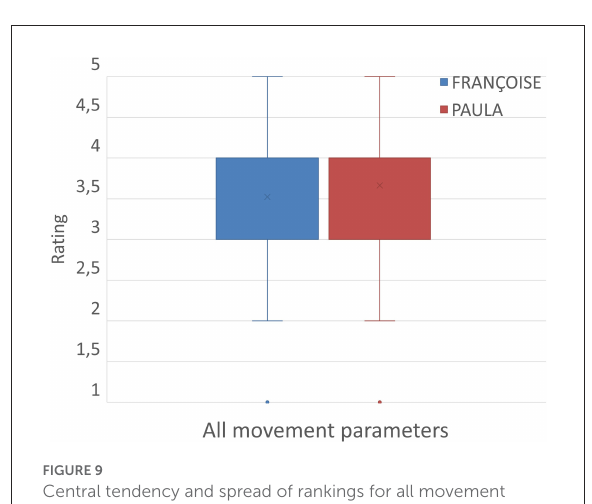
strings of fingerspelling in isolated strings as well as within linguistic